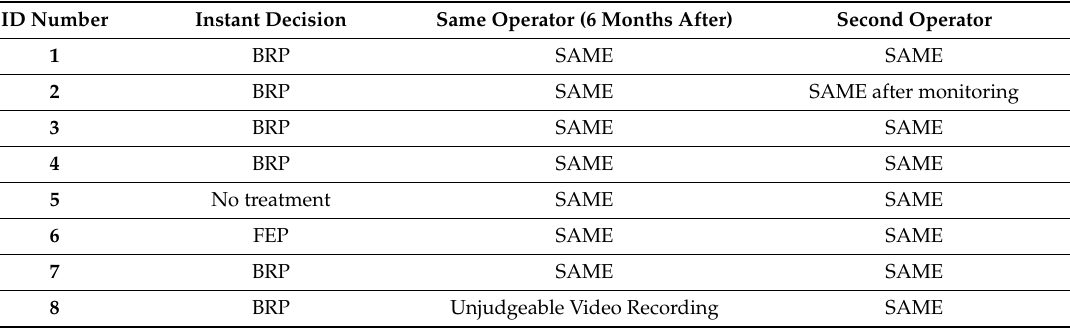
Table 2. Results of DISE interpretations based on 5VsEs in the operating room and after 6 months by the same operator compared to a second external